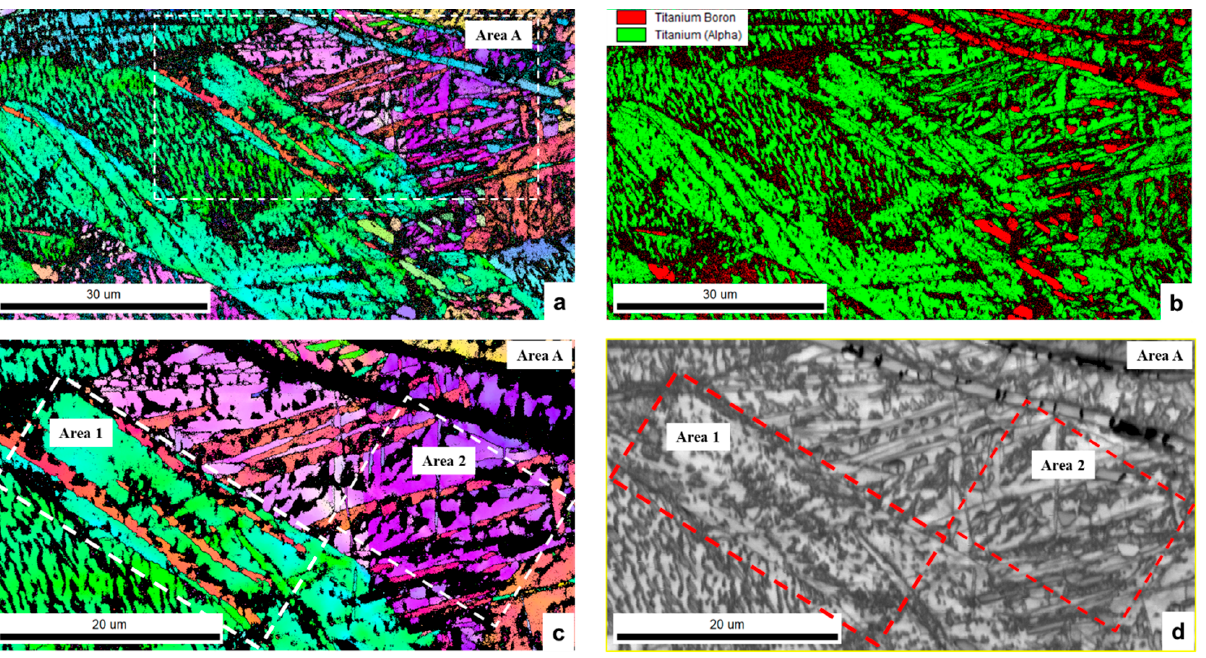
Figure 9. SE ‐ SEM image showing ( a ) the typical subsurface cross ‐ section microstructure of a PTA ‐ SFFF Ti–TiB coupon subjected to shot peening and polishing treatment, as described in Section 3.3, etched in Kroll’s etchant. ( b ) The higher magnification image from the enclosed box region showing microstructural hatched features due to shot peening.